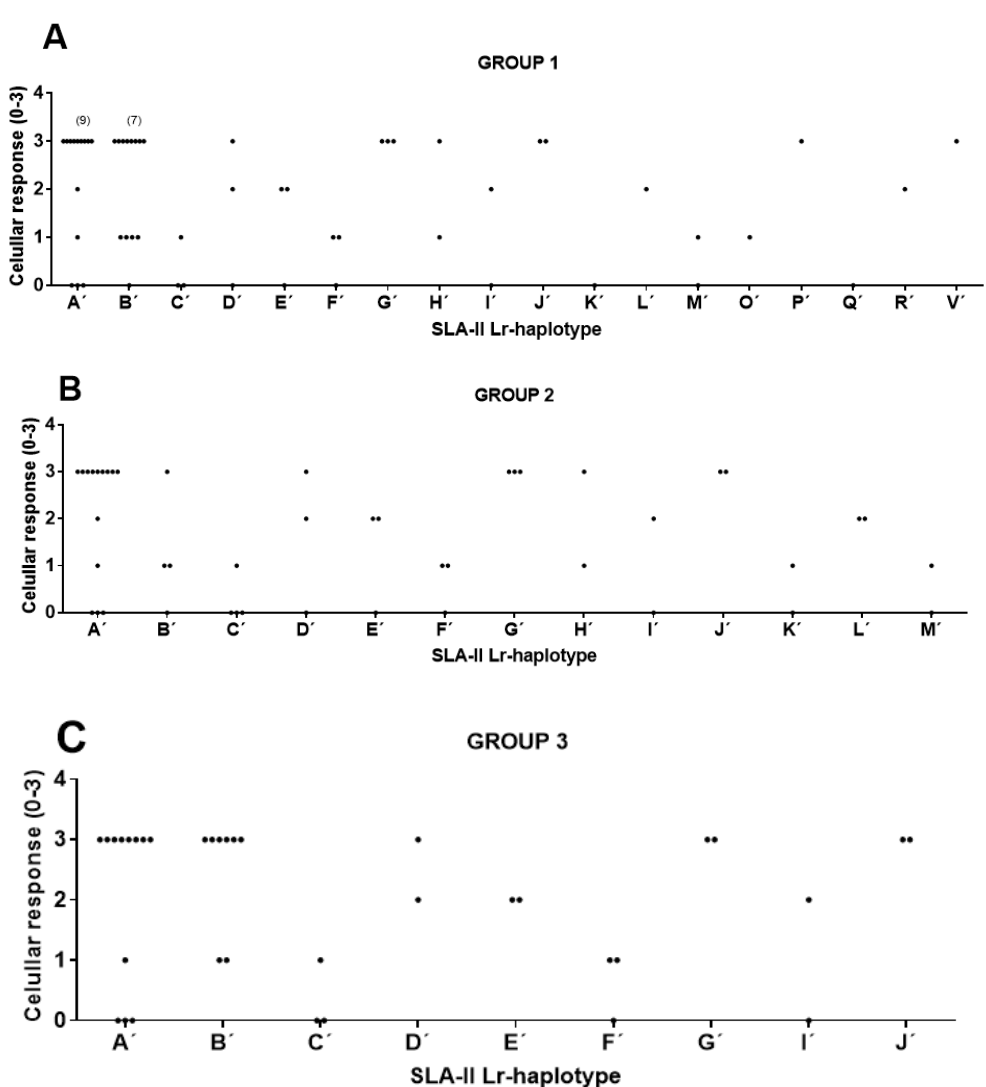
Figure 3. Significant correlations between SLA-II Low-resolution (Lr) haplotypes and cellular response in immunized pigs from groups 1, 2, and 3. Animal group composition as in Table S3. Cellular response values as in Table S2 and Table 1. ( A ) Group 1. Significance: χ 2 α = 0.022 *, LR χ 2 α = 0.034 *, Fisher’s exact α = 0.003 *, Cv = 0.66. ( B ) Group 2. Significance: χ 2 α = 0.010 *, LR χ 2 α = 0.014 *, Fisher’s exact α = 0.001 *, Cv = 0.67. ( C ) Group 3. Significance: χ 2 α = 0.004 *, LR χ 2 α = 0.008 *, Fisher’s